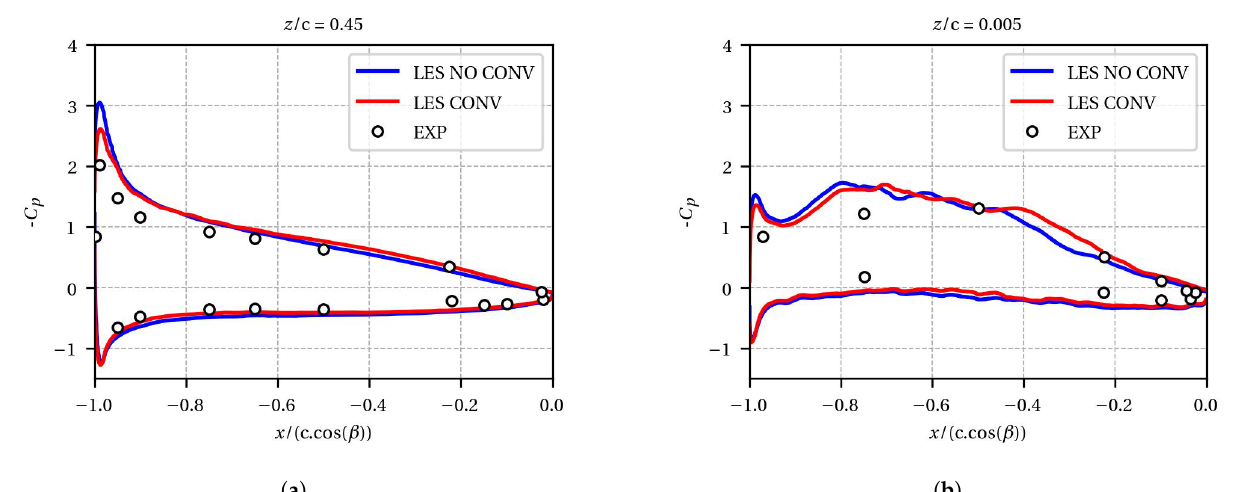
Figure 6. Mean pressure coefficients on the airfoil at midspan, z /c = 0.45 ( a ) and at the tip, z /c = 0.005 ( b